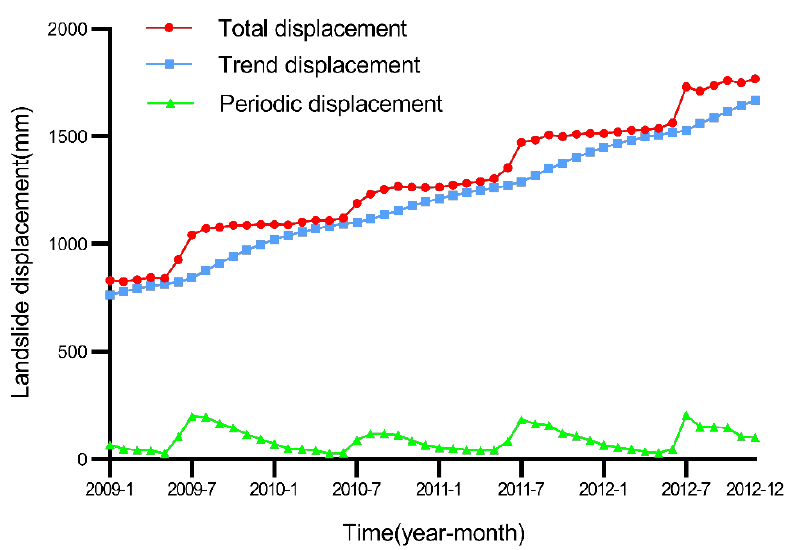
Figure 10. Decomposition results of the displacements measured at station ZG111.